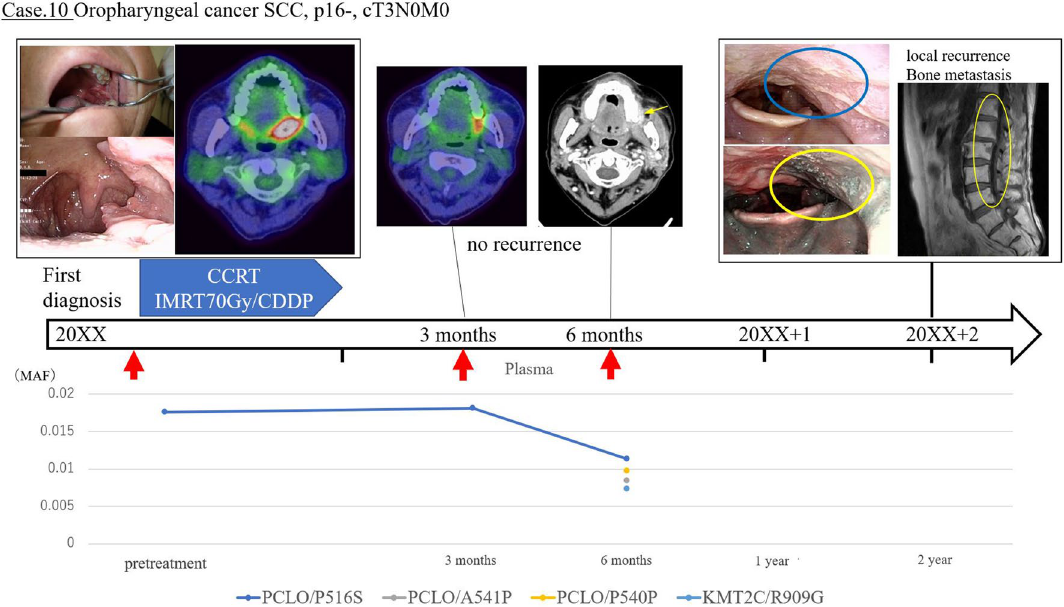
Figure 3. Sample case for use of plasma circulating tumor DNA to detect HNSCC (Case 10). Clinical course of patient #10. This patient exhibited a p16-negative oropharyngeal carcinoma cT3N0M0 and was treated with chemoradiotherapy. The patient was treated with a cisplatin combination. Before treatment, ctDNA was detected via PCLO /P516S. Post-treatment imaging studies showed that the tumor had disappeared, but ctDNA was still detected 6 months after treatment. Tumor recurrence was detected 2 years after treatment during follow-up imaging.